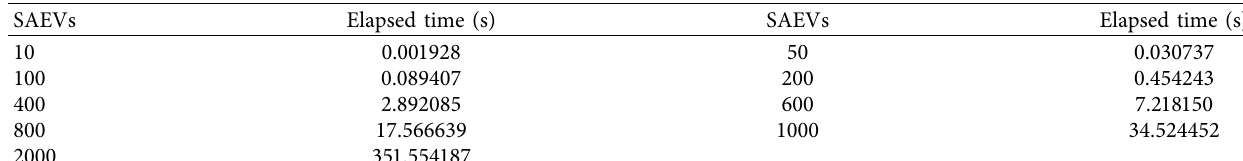
Figure 3: Multiaction allocation instructions of the toy example at time slot t Table 7: Elapsed time of the KM algorithm for different fleet sizes of SAEVs.